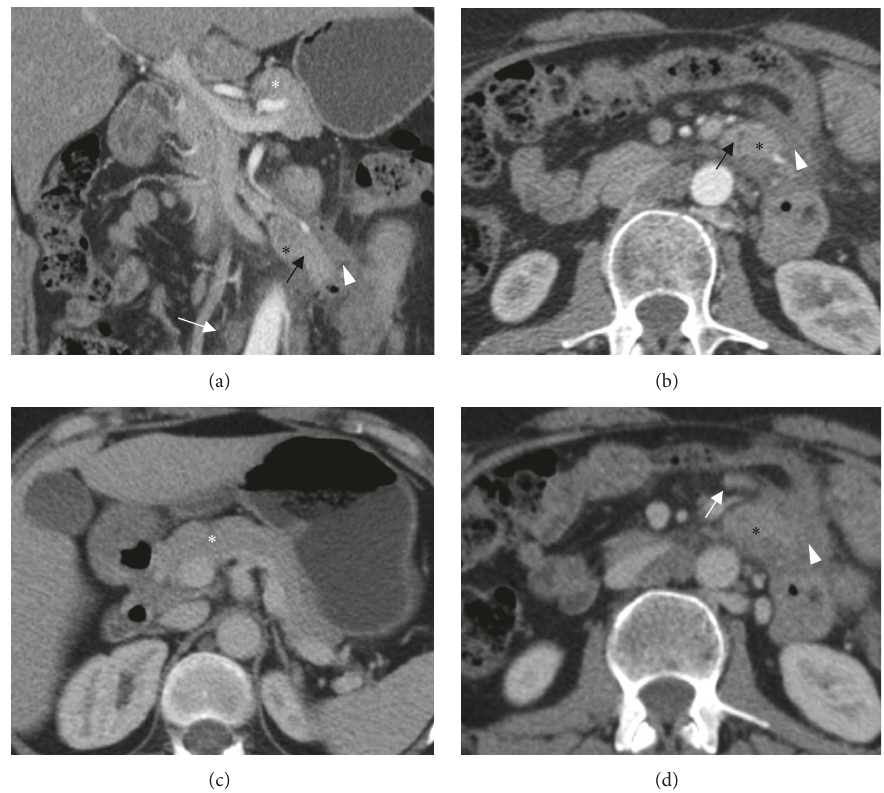
Figure 3: CT scan performed six weeks after admission. (a-b) Coronal and axial image in the arterial phase. (c-d) Axial images in the portal venous phase. Intra-abdominal free fluid is completely resolved. Heterotopic pancreas (black asterisks) in the mesentery with attenuation characteristics after intravenous contrast comparable to the orthotopic pancreas (white asterisks) . Moreover, presence of a central duct is suggested (black arrow) . There is an apparent decrease in inflammatory changes (white arrowheads) surrounding the heterotopic pancreas, though several adjacent mesenteric lymph nodes have increased in size (white arrows) .